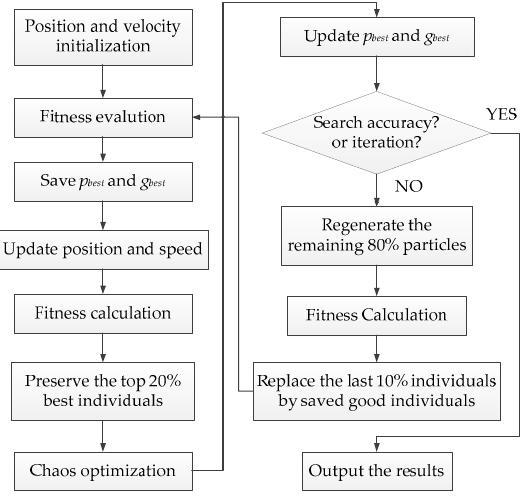
Figure 5. The flowchart of proposed modified chaos particle swarm optimization (MCPSO) algorithm.